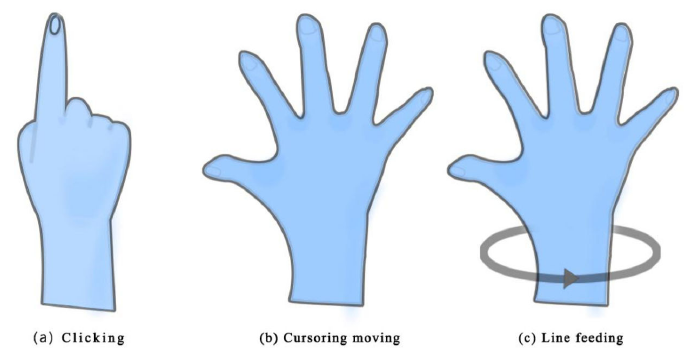
Figure 3. The different interactive gestures. ( a ) Clicking; ( b ) cursor moving; ( c ) line